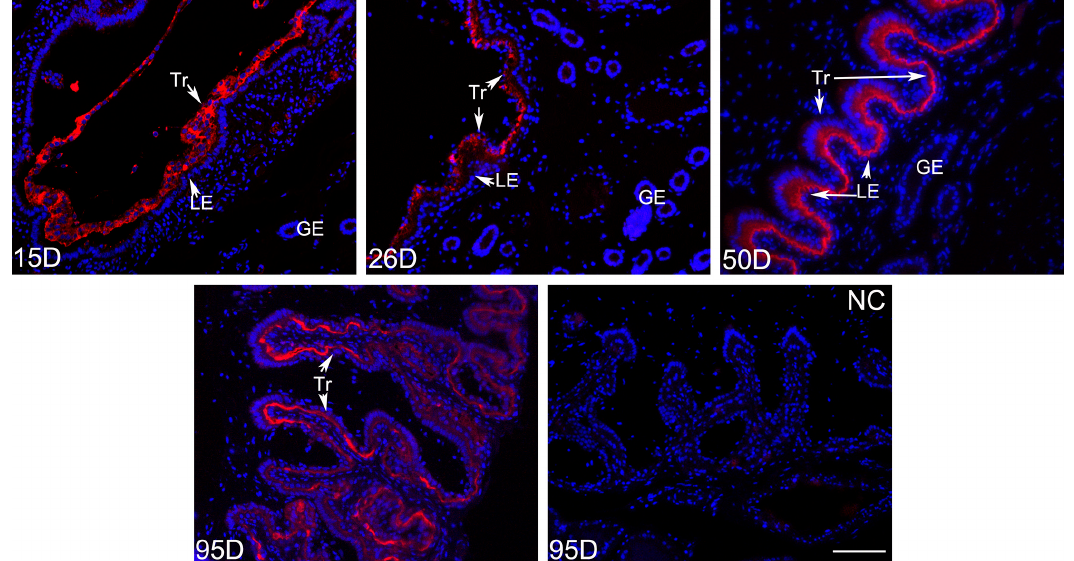
Figure 3. Immunofluorescence analysis of PLET1 at the maternal-fetal interface in pigs. PLET1 was identified by a red fluorescence. The section stained with normal rabbit IgG was used as the negative control. On Days 15 and 26 of gestation, the immunoreactive-PLET1 was observed in the trophoblast cells and the positive signals were located mainly in cytoplasmic region. On Days 50 and 95 of gestation, PLET1 protein gradually accumulated to the apical side of the trophoblast cells towards the uterine epithelium. Tr: trophoblast cells; LE: luminal epithelium; GE: glandular epithelium; D: day of gestation; NC: negative control. Scale bar = 100 μ m.